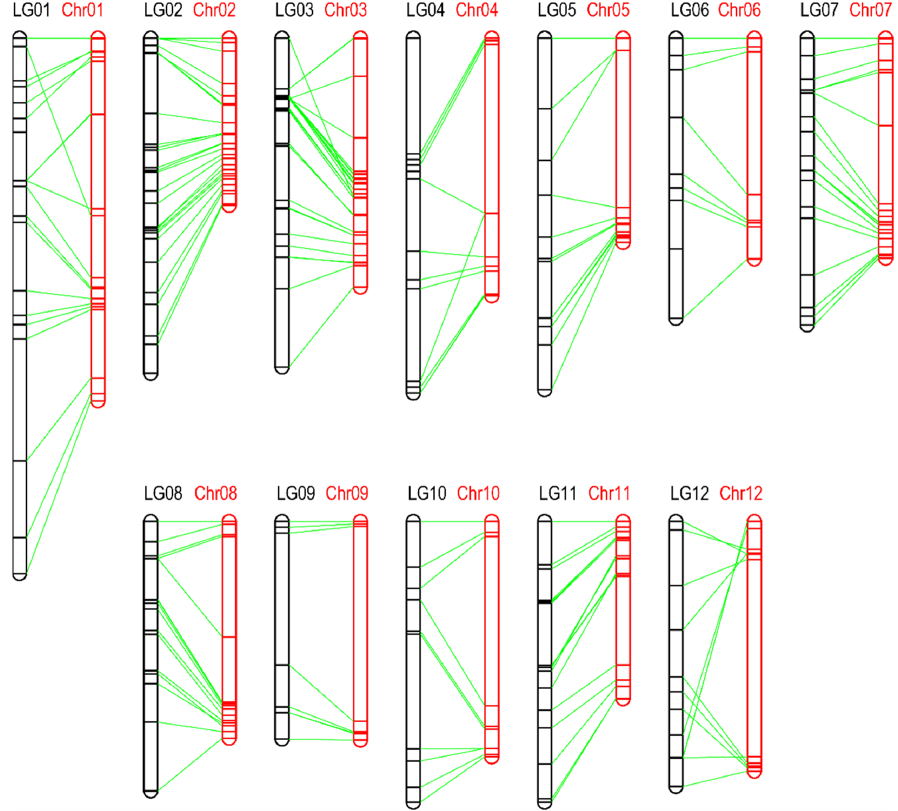
Figure 1. Potato CB-SNP genetic map and comparison with the DM1-3 genome physical map. LG1–LG12 (indicated with black) indicate 12 linkage groups constructed with 258 SNP markers. Chr1–Chr12 (indicated with red) indicate 12 potato chromosomes on the physical map. The synteny between the genetic and physical maps is showed with green lines.